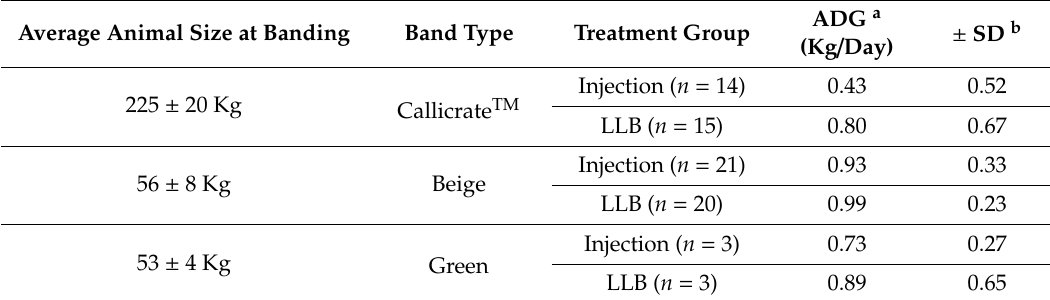
Table 3. Average daily gain for control versus treatment animals.